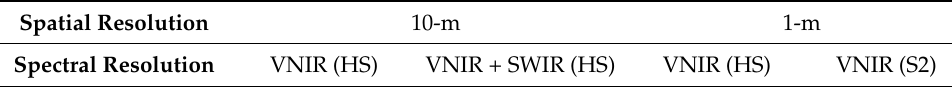
Table 5. Simulated images from native hyperspectral image degradation. Spatial